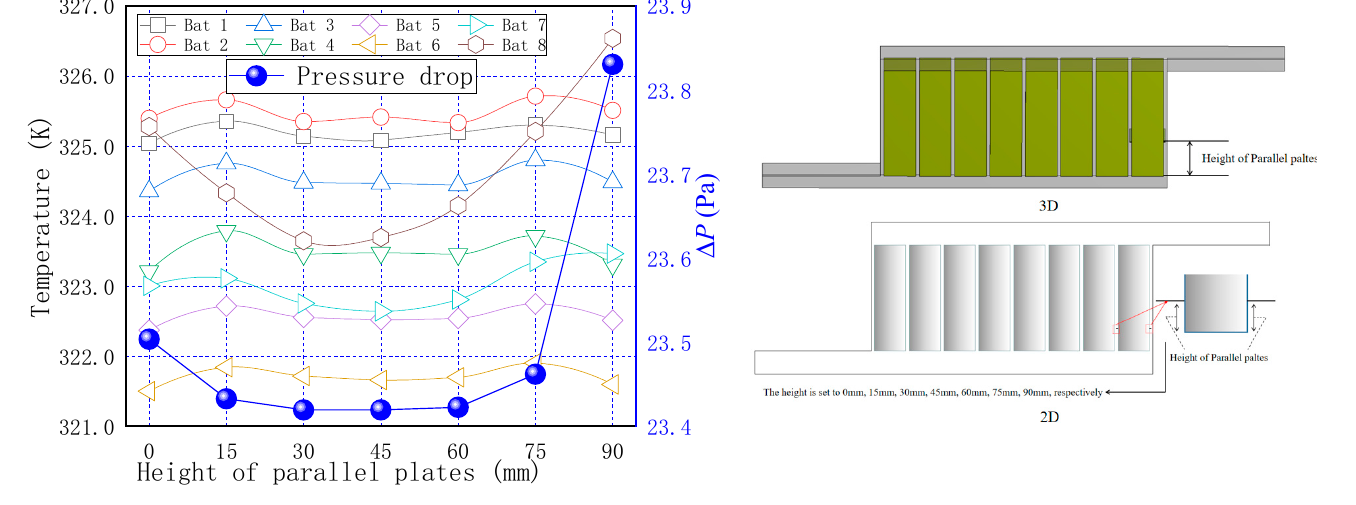
12 of 16 Figure 11. Effect of the length of parallel plates on temperature and velocity distribution of the model; ( a ) temperature distribution in case2; ( b ) velocity distribution in case2; ( c ) temperature distribution in case9; ( d ) average distribution in case9. 3.3. The Influence of the Position of Parallel Plates Due to the best cooling performance, the BTMS with two 1.5 mm parallel plates (case2) was chosen as the next research object. The effect of the installation position of parallel plates was studied. In the above study, the parallel plate was installed at the bot- tom side of the battery. In this section, as shown in Figure 2, the height of parallel plates was changed at the same time from 0 to 90 mm with a 15 mm step size, and the calculation results about the temperature and velocity distribution of the battery pack are shown in Figure 12. As shown in Figure 12a, only the temperature of and seventh battery cell fluc- tuated considerably, the maximum fluctuation was 2.89 and 0.82 K, respectively, and the eighth battery temperature presented a lower value when the height was 30 or 45 mm. Other battery cells’ temperature all kept the fluctuation within 0.5 K. The pressure drop was less affected by the installation height of parallel plates, it showed a trend of decreas- ing first and then rising. Figure 12b compares the airflow average velocity in each cooling